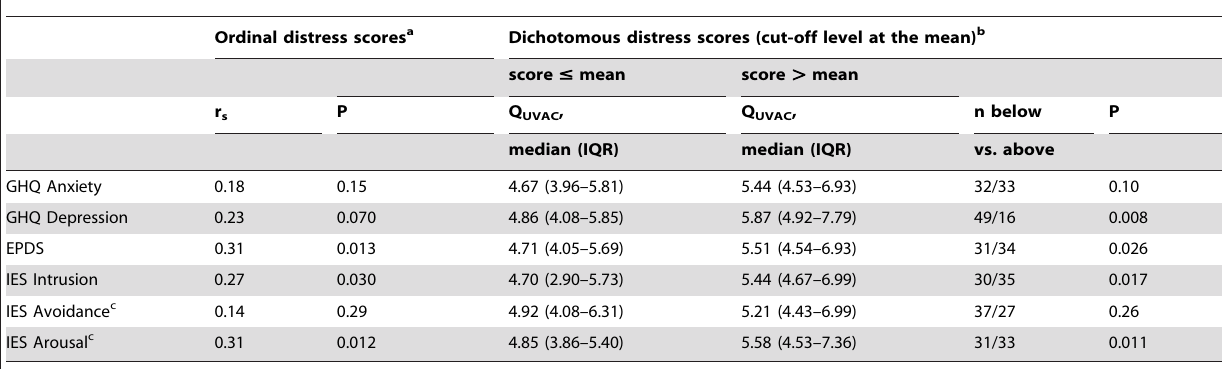
Table 3. Associations between second trimester psychological distress scores at 16 weeks and third trimester normalized umbilical vein volume blood flow (n= 65).